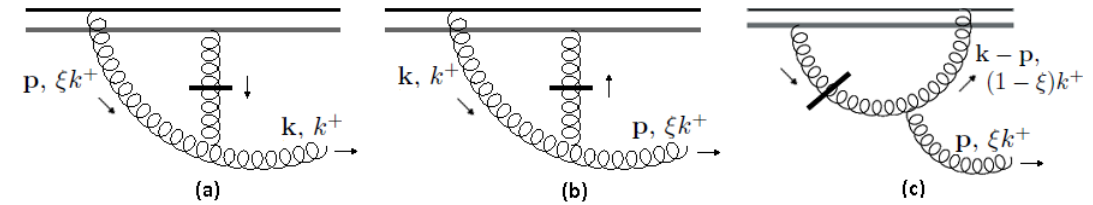
Figure 7 . One gluon production via instantaneous interaction. (a) - Due to the instantaneous interaction, the gluon that was originally emitted can either gain or lose longitudinal